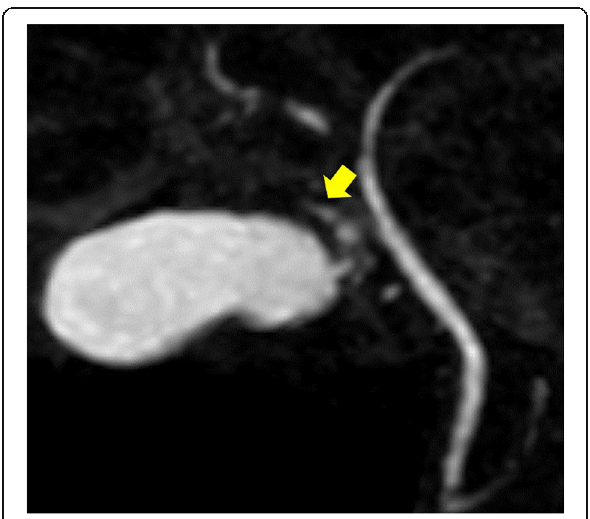
Fig. 2 Magnetic resonance cholangiography showing the cystic duct branching from the common bile duct and an aberrant right hepatic duct (arrow) connecting to the cystic